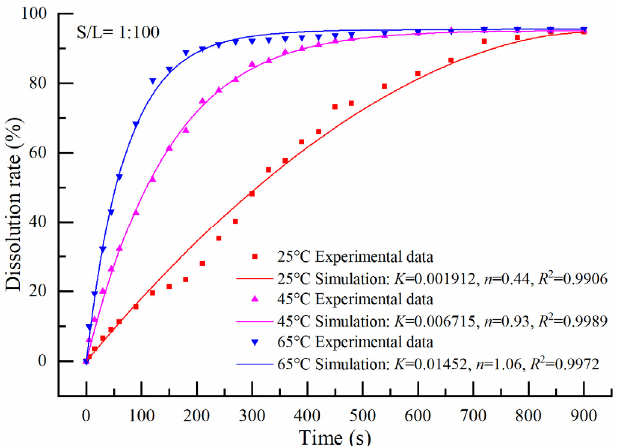
Figure 5. Effects of temperature on chloride ion dissolution rate with S/L ratio of 1:100 and stirring speed of 600